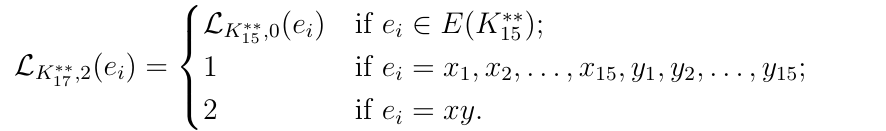
-magic labeling of K 3